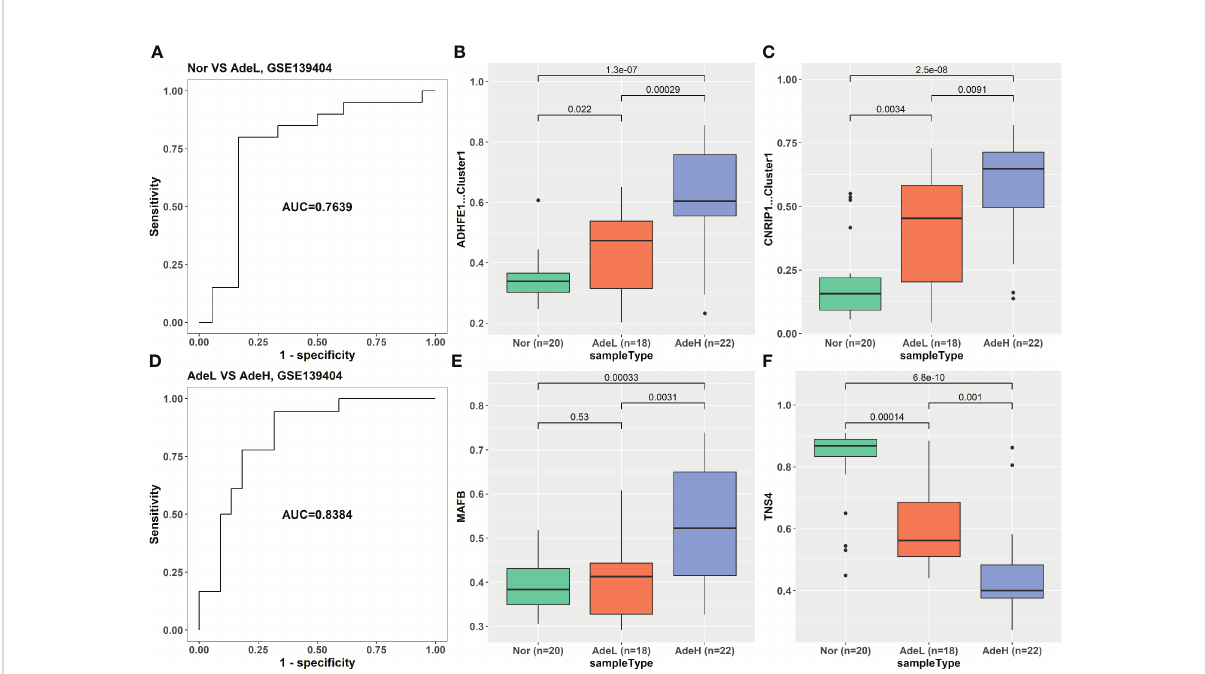
FIGURE 5 The classi fi cation ability and methylation levels of the four iRFE MDGs in dataset GSE139404. (A) The classi fi cation performance of the LDA model for normal and low-grade adenoma samples. (D) The classi fi cation performance of the LDA model for low- and high-grade adenoma tissues. (B, C, E, F) The methylation levels of the four iRFE MDGs in different tissues. (B) ADHFE1-Cluster1. (C) CNRIP1-Cluster1. (E) MAFB. (F) TNS4. Nor, healthy normal tissues; AdeL, low-grade adenoma tissues; AdeH, high-grade adenoma tissues; iRFE, iterative recursive feature elimination; MDGs, methylation-driven genes; LDA, linear discriminant analysis.